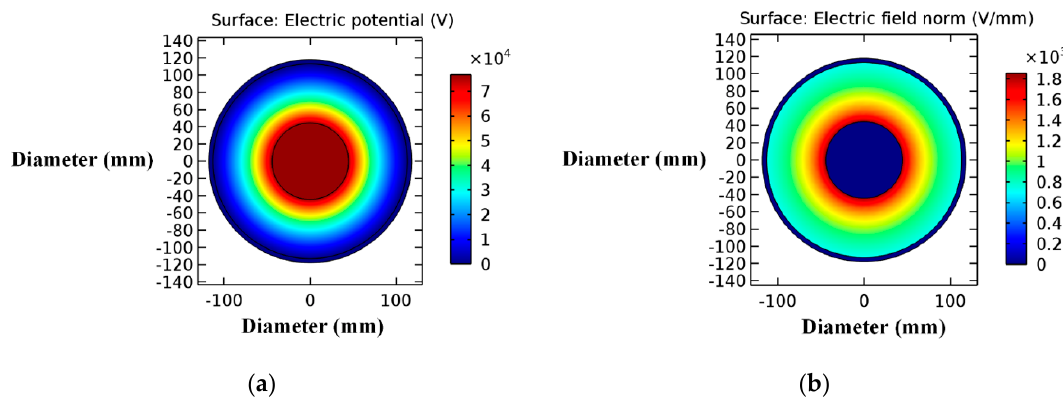
Figure 2. ( a ) Potential difference and ( b ) field distribution apropos of a conventional gas-insulated transmission line (GIL) regarding specimen 1 of Table 2.